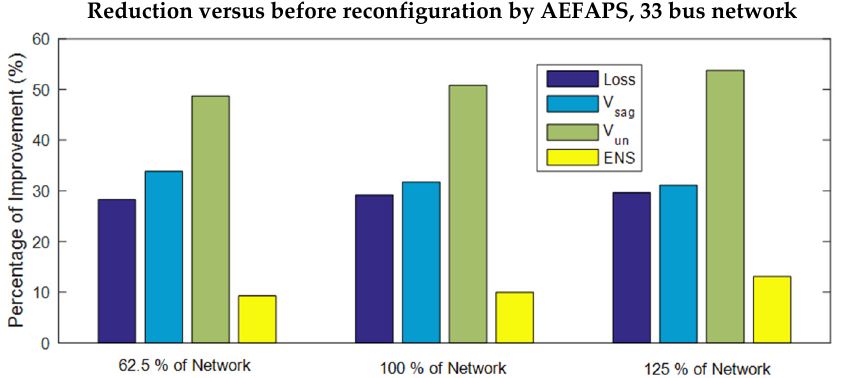
Figure 15. Percentage of improvement of objective function indices by AEFAPS for an unbalanced 33-bus network.